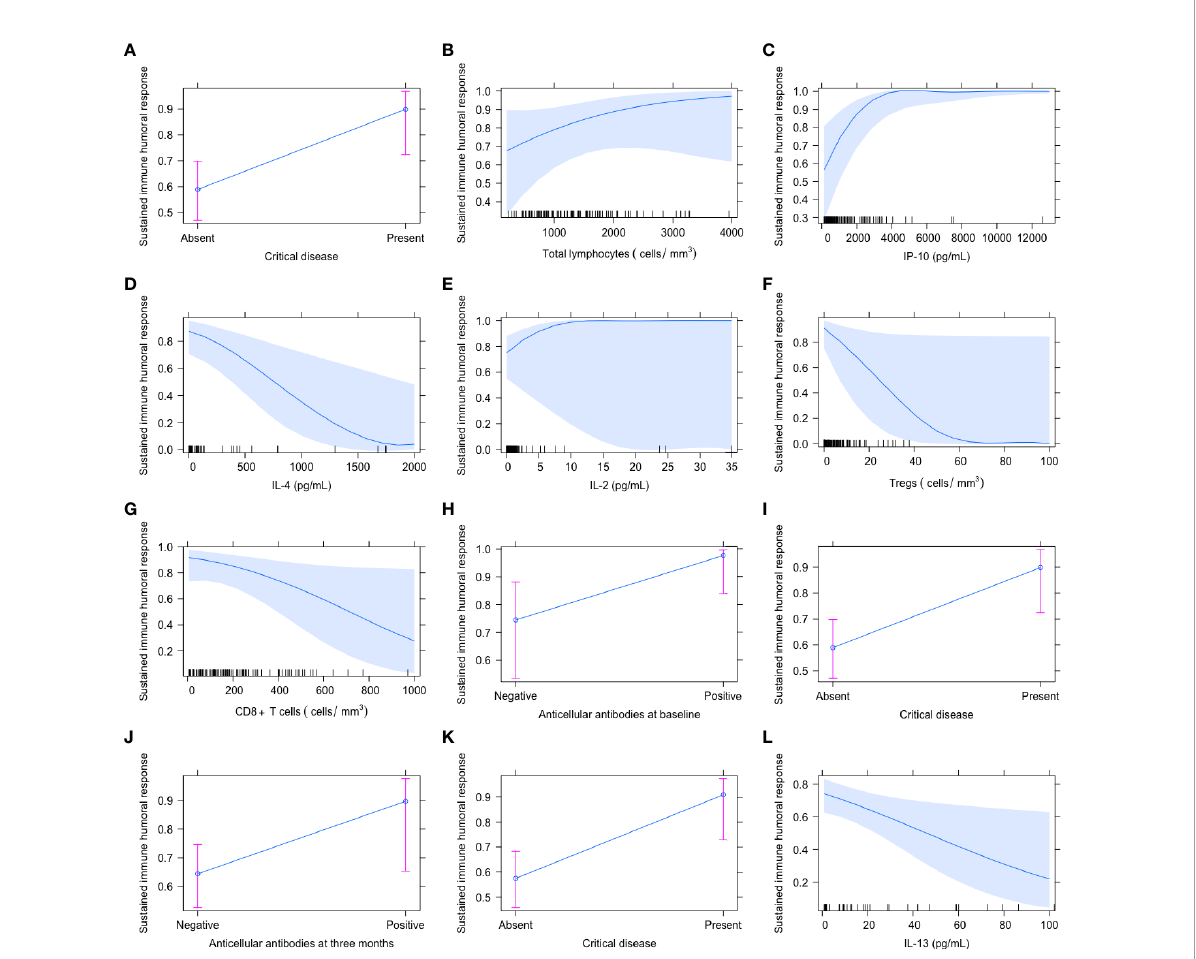
FIGURE 4 Independent variables associated with the presence of a sustained immune humoral response at baseline (A – H) , 3 (I, J) and 6 months (K, L) after COVID-19 onset. The proportion of patients with a sustained immune humoral response was de fi ned as those maintaining anti-SARS-CoV- 2 IgG titers above 4.99, which has been shown to correlate with a viral neutralizing capacity. The graphs represent the effect of the explanatory variables on the probability to have a sustained immune humoral response, being the maximum probability 1